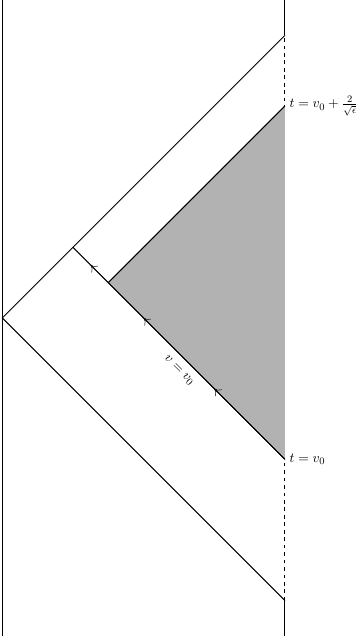
Figure 3 . Penrose diagram of AdS 2 × S 2 . The dashed boundary signifies that this AdS 2 is maintaining connection with the exterior of Reissner-Nordström. An ingoing pulse of energy (cid:15) enters the extreme throat (Poincaré patch) at t = v 0 . The black hole horizon shifts and the throat becomes near-extreme (shaded Rindler